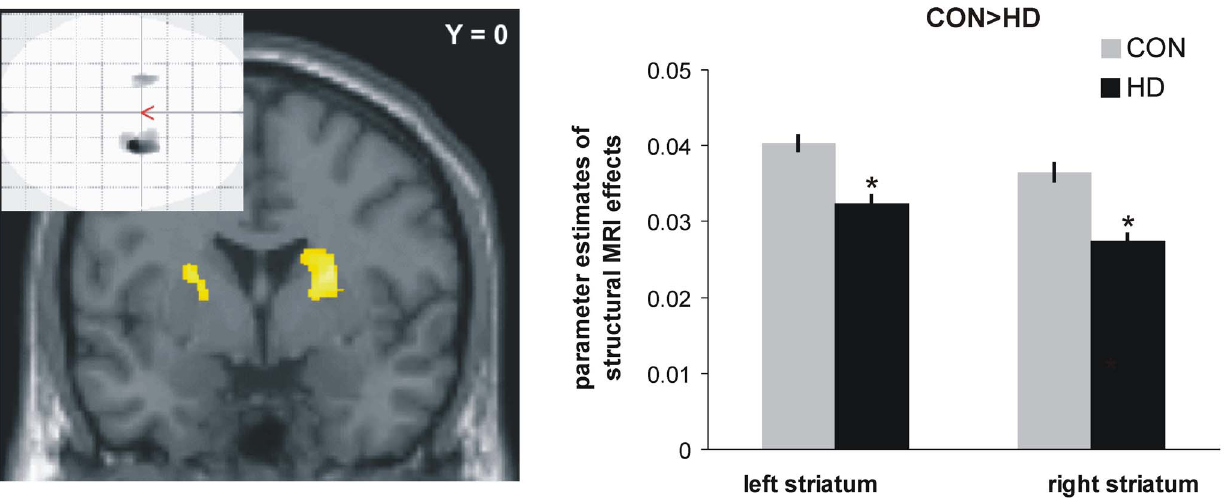
Fig. 2. Comparison of structural grey matter images: decreased dorsal striatal volume in mutation carriers as compared to control subjects (*: p , 0.001, uncorrected, number of voxels per cluster . 20 for illustration purposes). Glass brain figure shows regional specificity of the results. Bar graphs on the right side depict parameter estimates of structural MRI volume differences between HD subjects and healty controls obtained from the left striatal peak voxel (x/y/z 52 24/2/15) and the corresponding voxel on the right side (x/y/z 5 24/2/15). HD: Huntington disease mutation carriers, CON: control subjects.